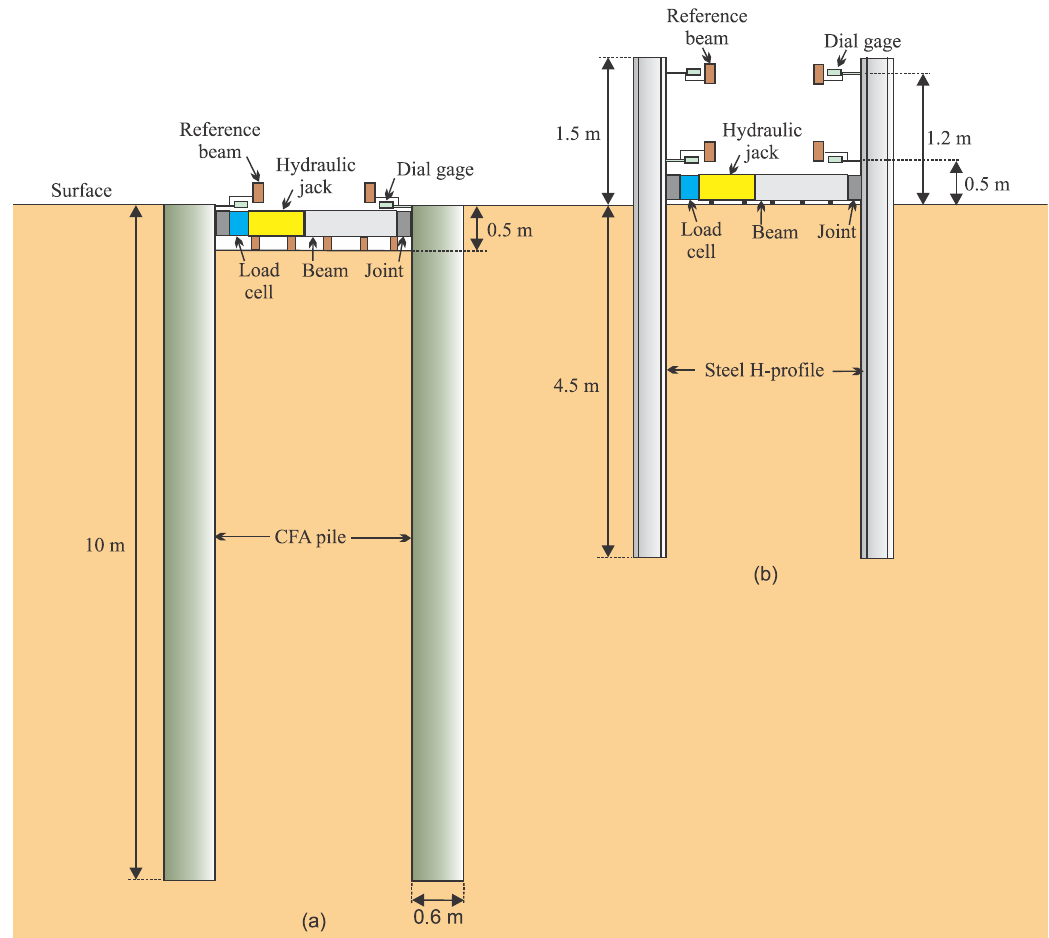
Figure 4. General scheme of testing assemblage and used apparatus: (a) CFA piles; (b) steel H-section